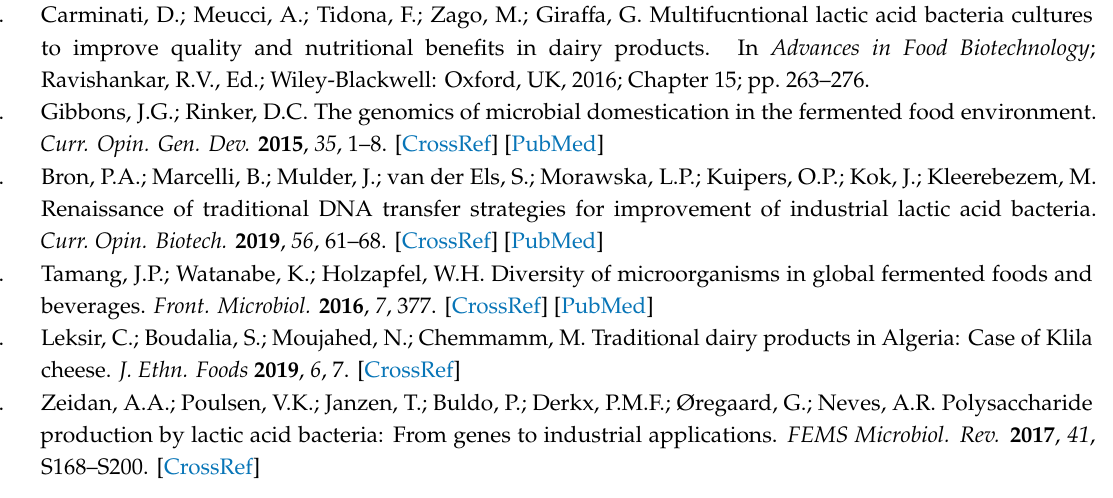
Figure S1 : genetic fingerprinting obtained by polymerase chain reaction (PCR) amplification of di ff erent genomic regions from L. plantarum LBIO1, LBIO14 and LBIO28 DNA. Figure S2 : SEC-MALLS chromatograms of the EPS-fraction extracted from milks fermented with the L. plantarum LBIO1, LBIO14 and LBIO28 strains. Table S1 : rheological parameters of milks fermented with L. plantarum LBIO1, LBIO14 and LBIO28 strains. Table S2 : acidification rate and increase of bacterial counts of milks fermented with L. plantarum LBIO1, LBIO14 and LBIO28 strains. Supplementary File 1 : ORF location, gene function, and % of identity of genes included in the eps clusters found in LBIO1, LBIO14 and LBIO28 L. plantarum genomes in comparison to that of the strain